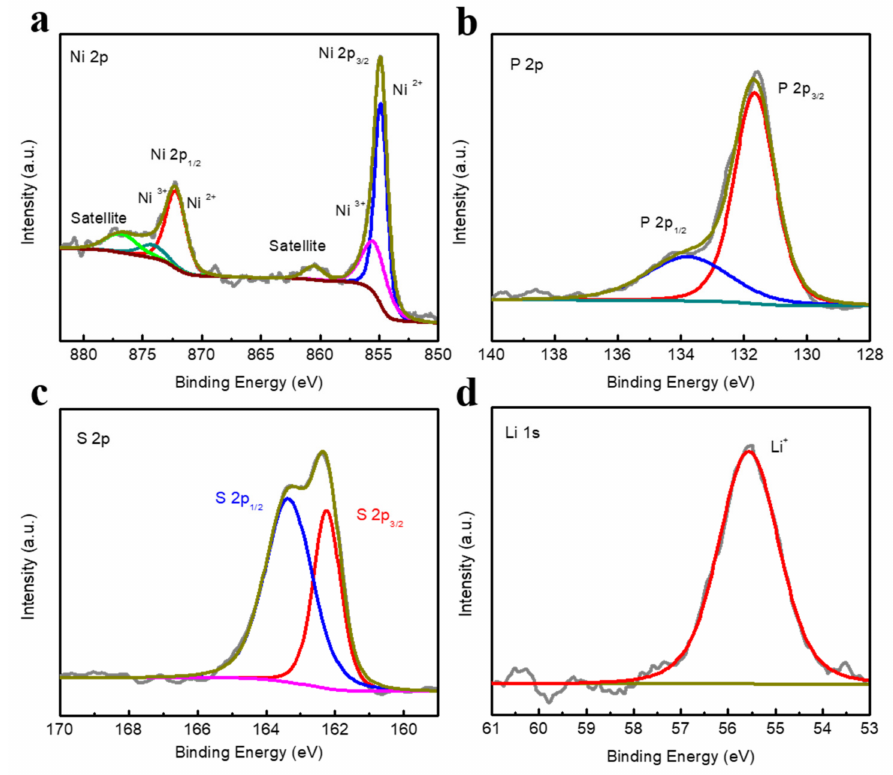
Figure 3. XPS (X-ray photoelectron spectroscopy) of the NLPS, ( a ) Ni 2p spectra, ( b ) P 2p spectra, ( c ) S 2p spectra, ( d ) Li 1s